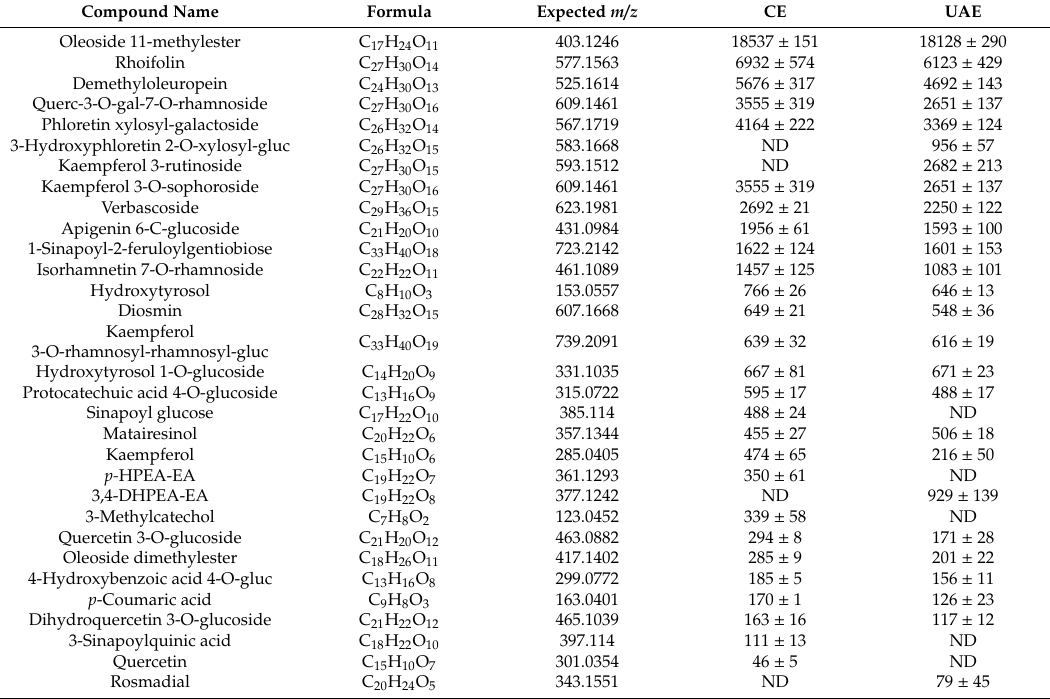
Table 1. Triple TOF-LC-MS-MS analysis of the polyphenols (mg / kg) in aqueous olive leaves extracts obtained with conventional (CE) and ultrasound-assisted (UAE)